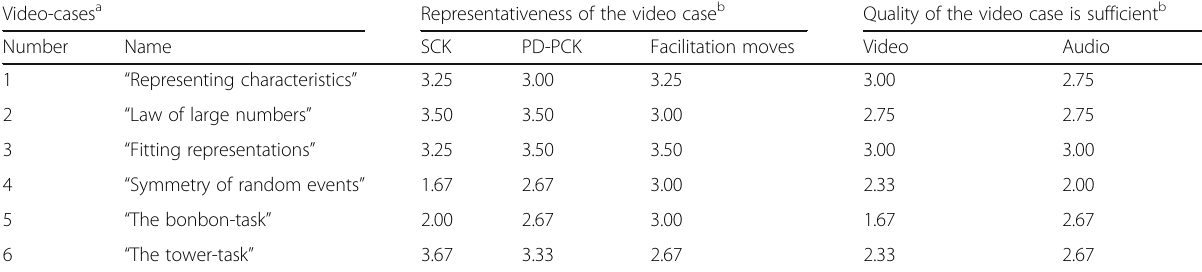
Table 5 Representativeness and quality of the video scenes Video-cases a Representativeness of the video case b Quality of the video case is sufficient